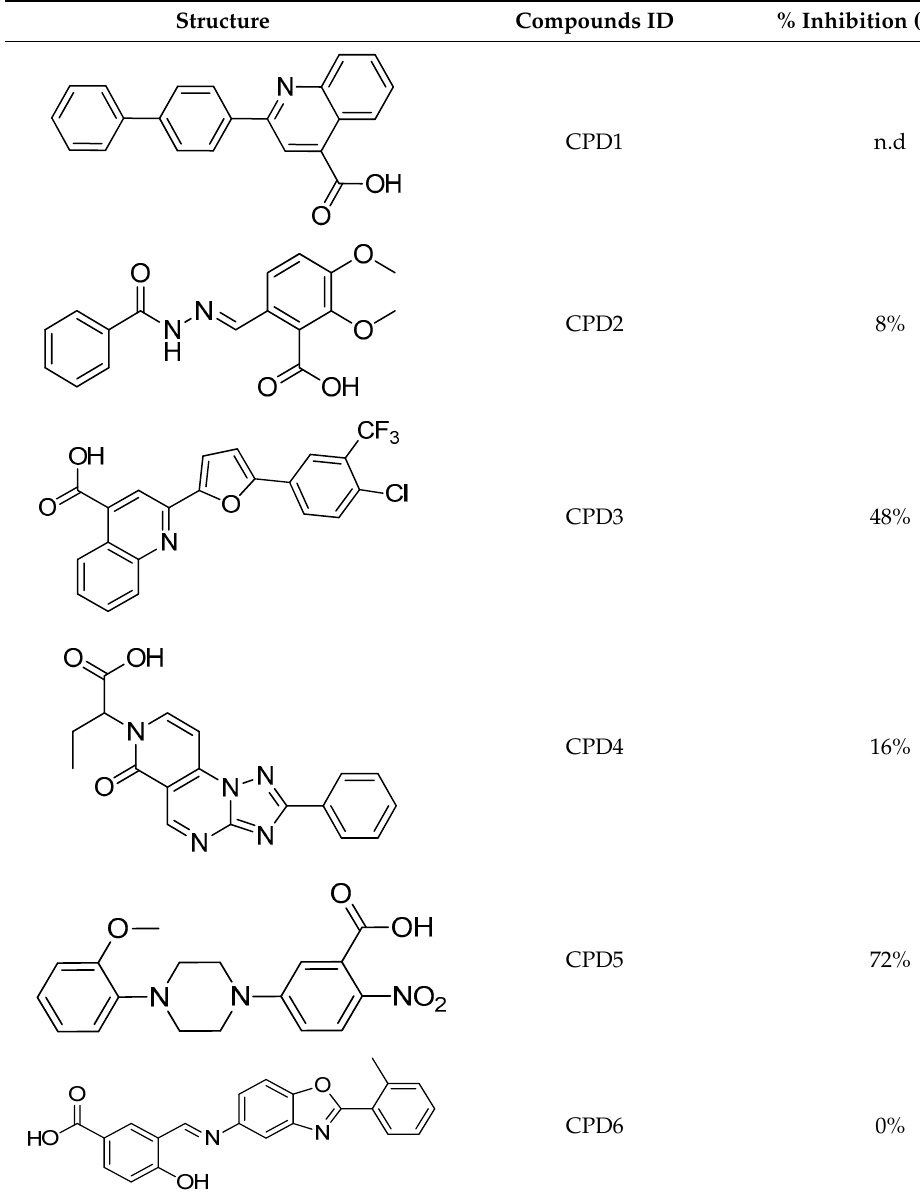
Table 3. Structure and h DHODH inhibition activity of the selected compounds.